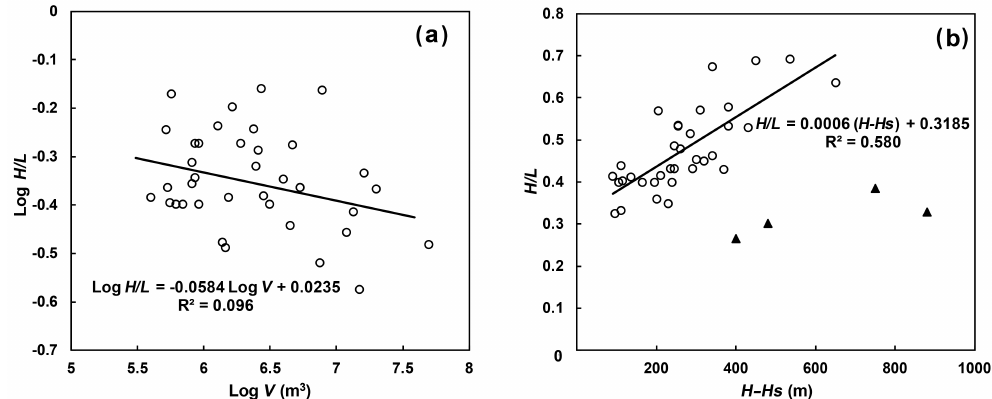
Figure 4. (a) Relationship between reach angle ( H/L ) and volume ( V ); (b) relationship between H/L and effective drop height of channel- ized rock avalanches ( H − Hs